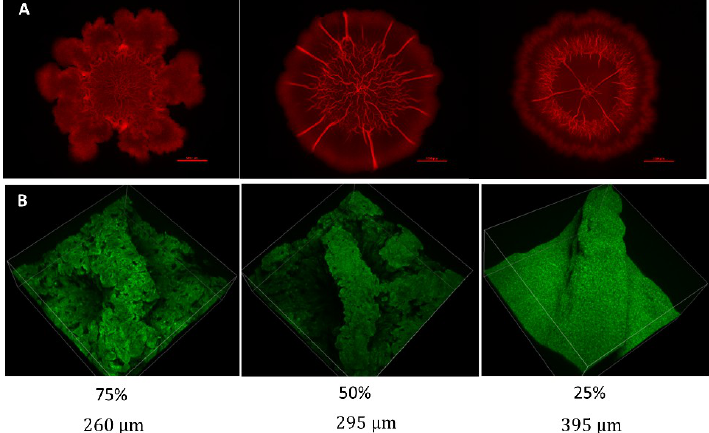
Figure 2. Changes in morphology. ( A ) Effect of LB agar concentration on B. subtilis macrocolony morphology. Mature non-nutrient deprived colony (top row, left), colony grown under 50% nutrient availability (top row, middle), 25% nutrient availability (top row, right). Scale bar—5000 µm; ( B ) Effect of progressive LB agar concentration on the structure of a single channel or “wrinkle”. Channel on the surface of a colony grown under 75% nutrient availability (bottom row, right), 50% nutrient availability (bottom row, middle) and 25% nutrient availability (bottom row,